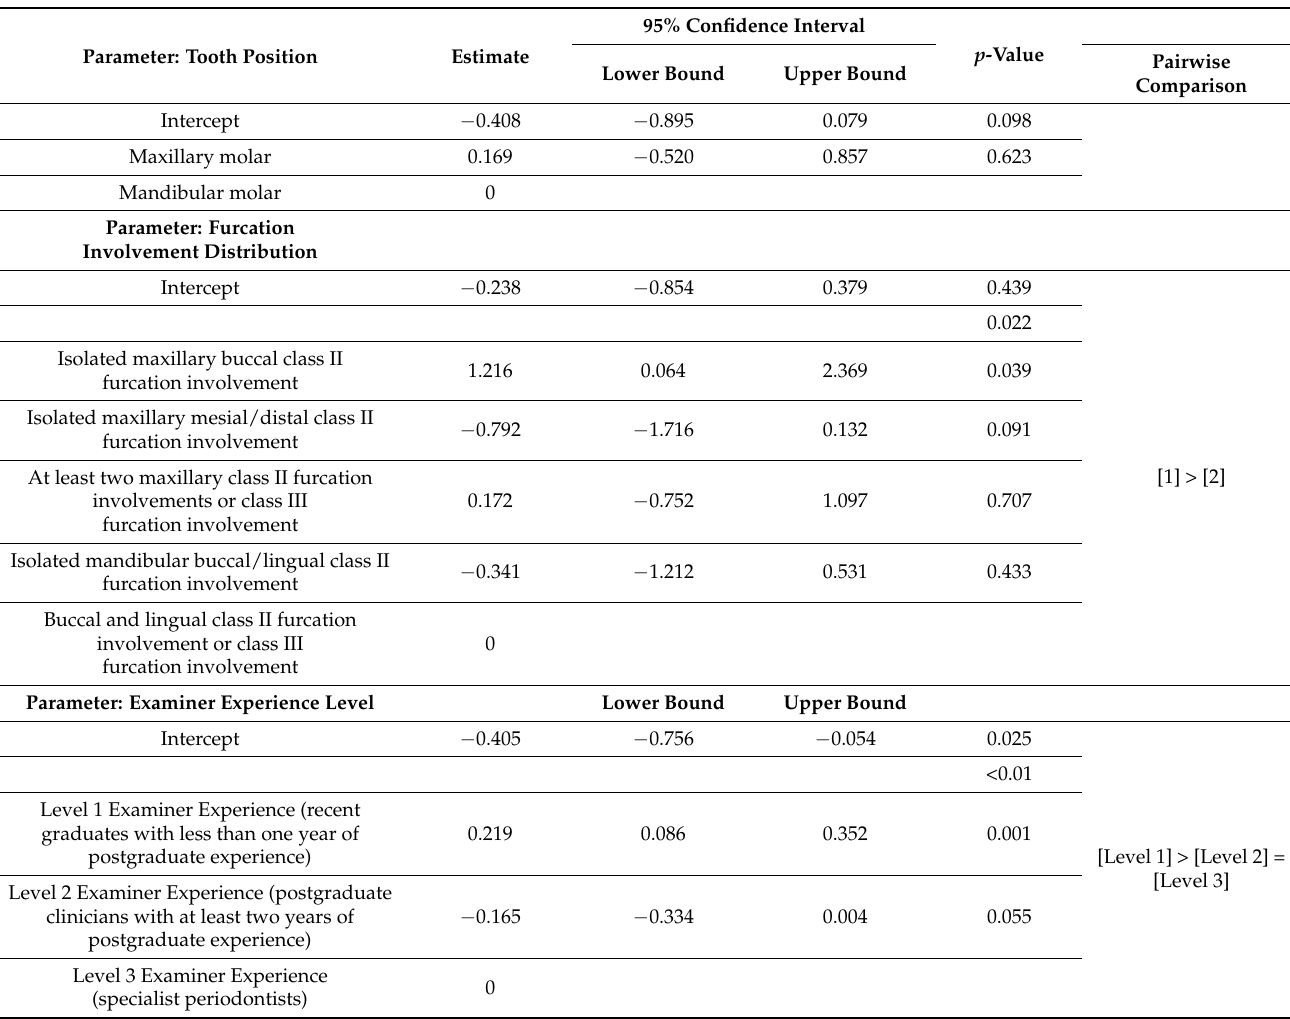
Table 4. The relationship between bias in vertical depth of furcation involvement measurement with tooth position, furcation involvement distribution, and examiner experience in the linear mixed model